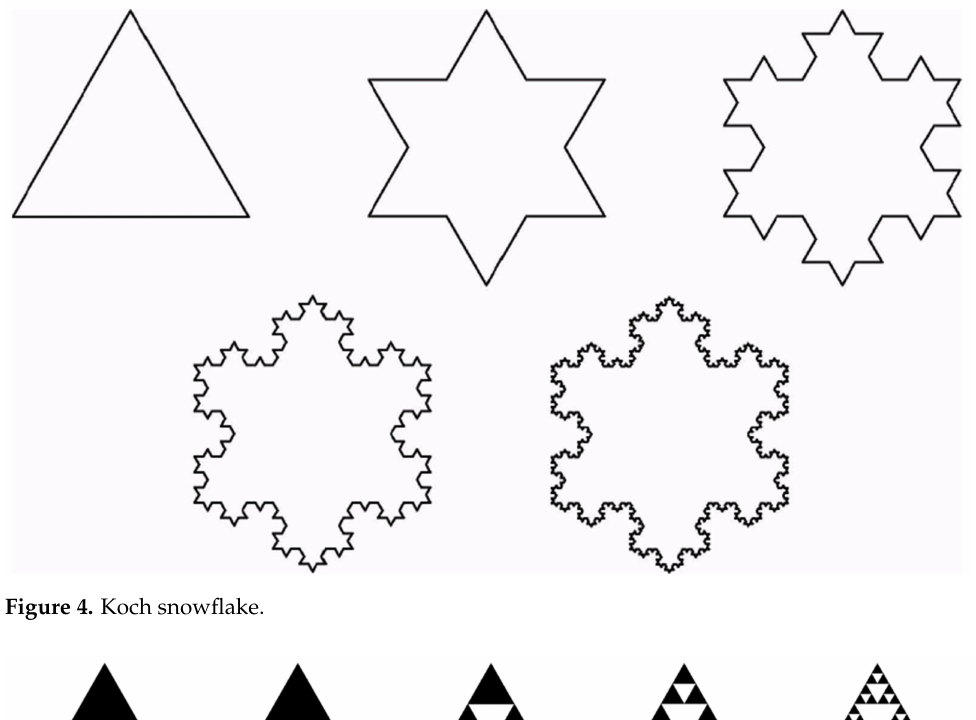
Figure 4. Koch snowflake.